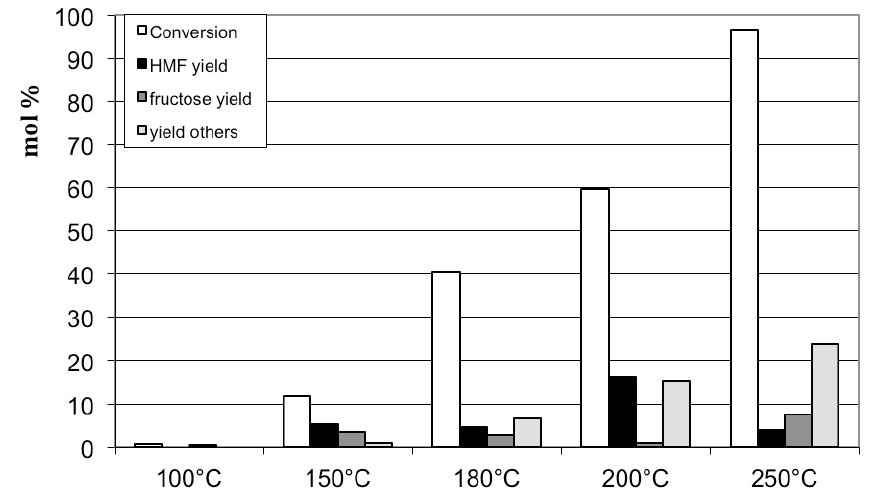
Figure 7. Glucose conversion in aqueous media in the presence of NbOH as a function of the